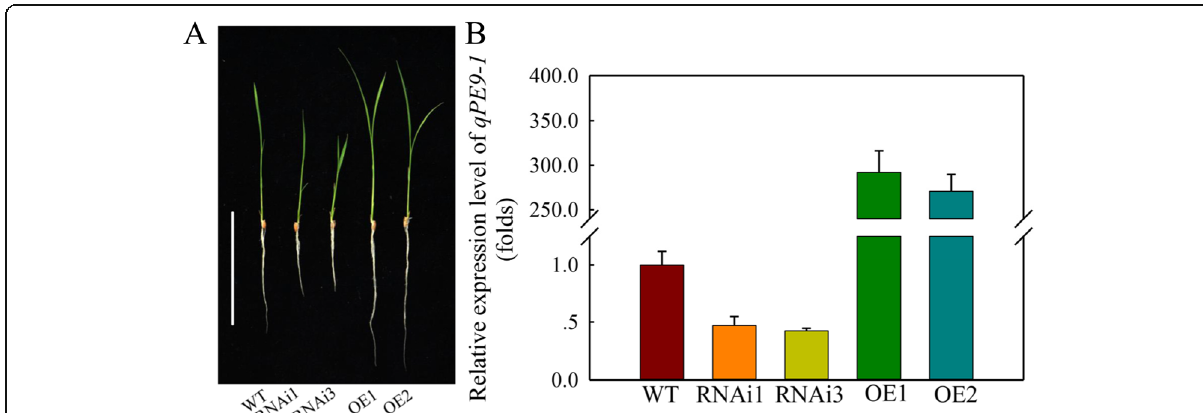
Fig. 2 Phenotype and expression level of qPE9-1 in wild-type rice and transgenic lines. ( A ) Phenotype of 7-d-old transgenic lines (WT, RNAi lines RNAi1 and RNAi3 or overexpressing lines OE1 and OE2 of qPE9-1 ). Scale bar: 10 cm. ( B ) Expression level of qPE9-1 in the RNAi and OE lines by